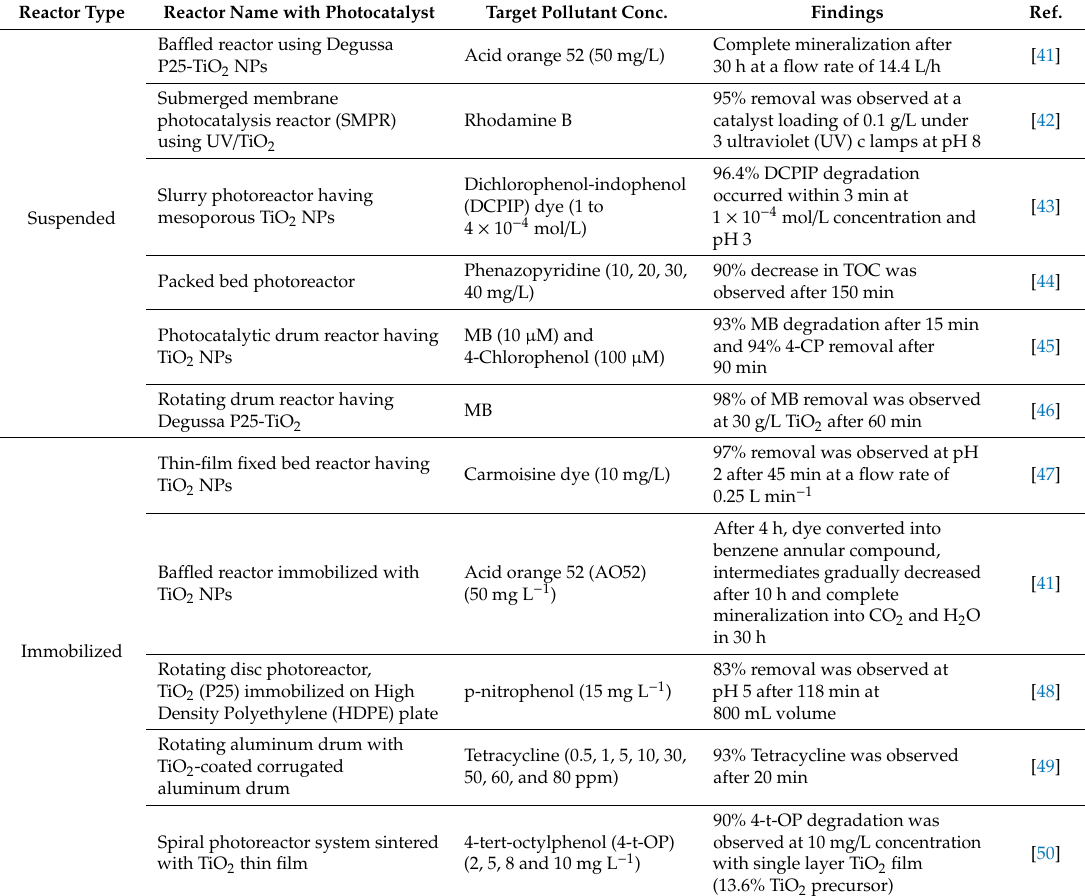
Table 2. Overview of various types of reactors, the catalyst employed, and their application in wastewater